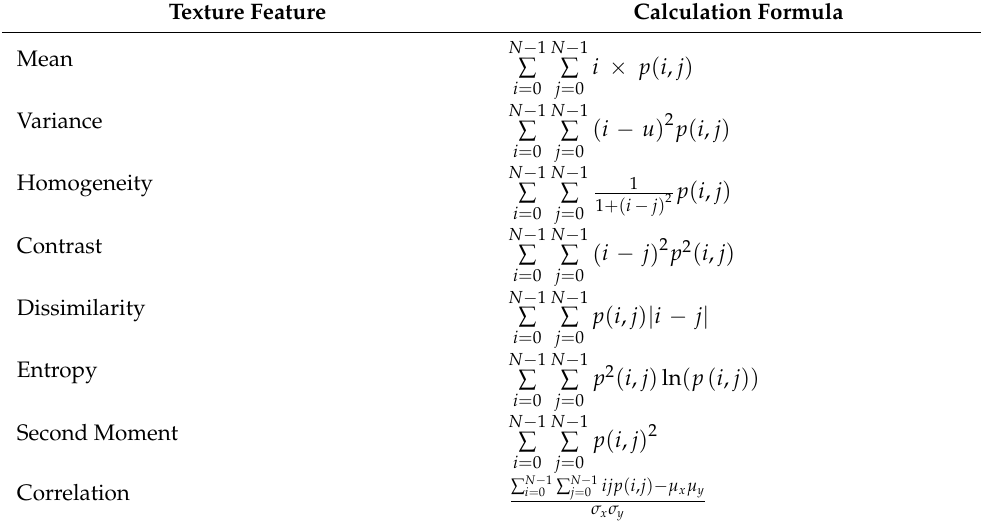
Table 5. Name and calculation formula of the GLCM texture features used in this